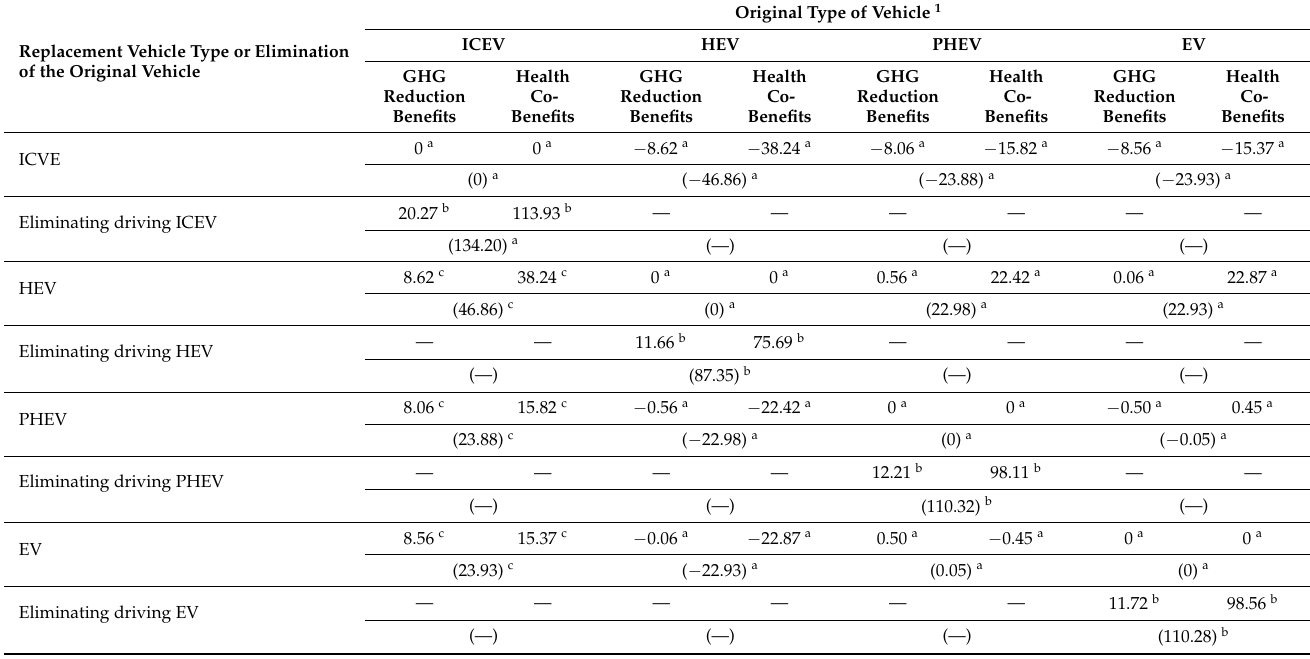
Table 9. Benefit matrix for GHG emission reduction and the corresponding health co-benefits from changing vehicle types.